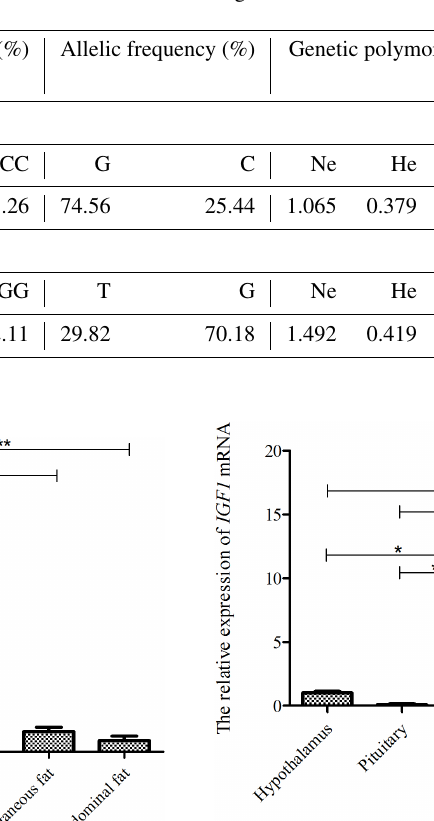
Table 2. Genetic diversity of two SNP loci in exon3 of IGF1 in the Shitou goose.